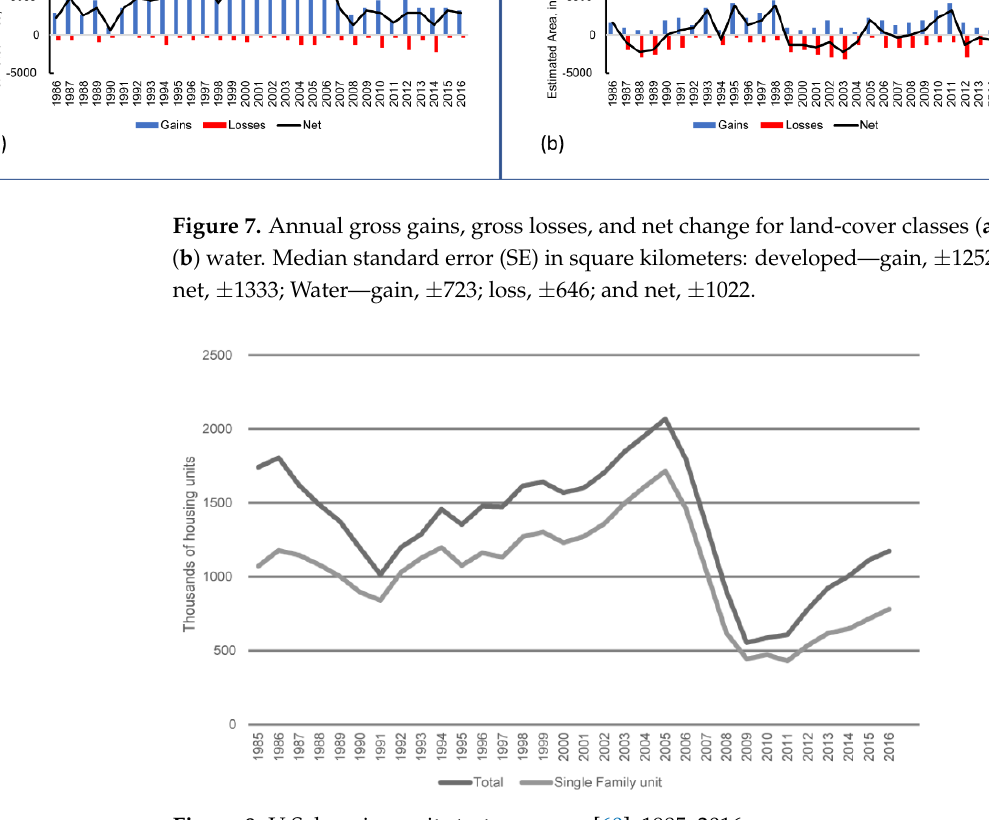
Figure 8. U.S. housing unit starts per year [60], 1985 – 2016.